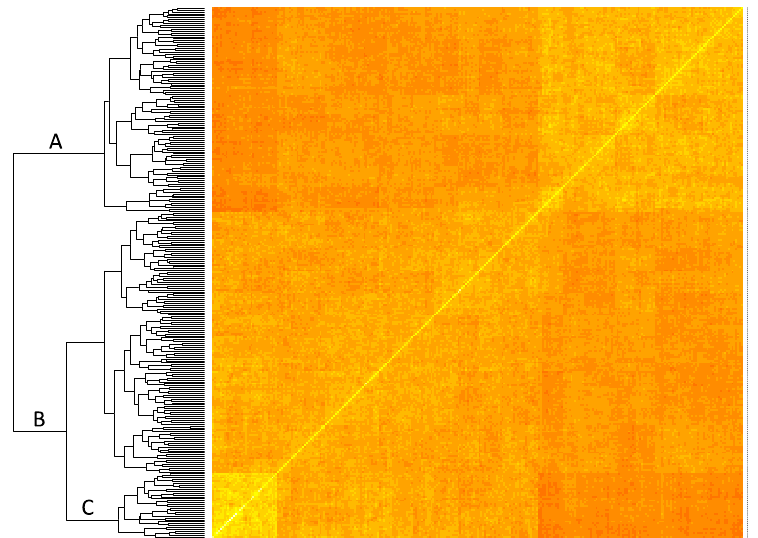
Figure 1. Additive relatedness matrix for ORUS 4304, ORUS 4305, and parents. Coefficients were estimated using the ‘AGHmatrix’ R package, VanRaden method, and 416 genome-wide markers. A = 4305; B = 4304; C = putative maternal inbred progeny.